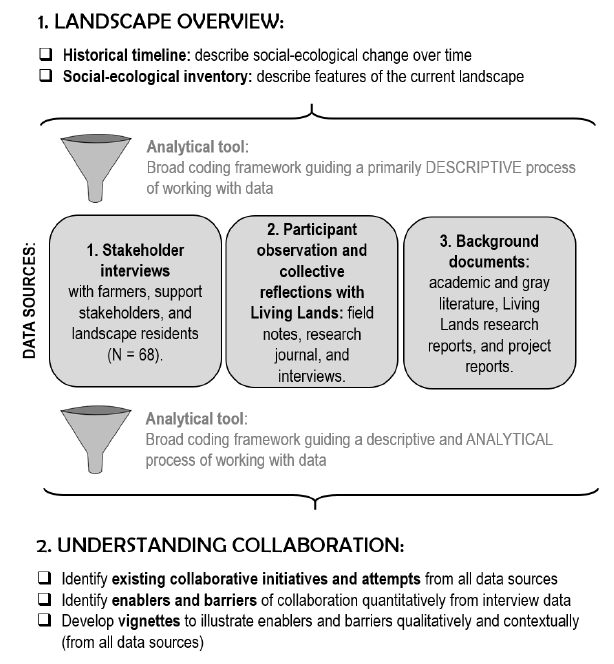
Fig. 3 . Qualitative data generation and analysis methods for the Langkloof case study. Data were generated for two main purposes: 1. To generate a landscape overview (case description), and 2. To gain an in-depth understanding of collaboration in the